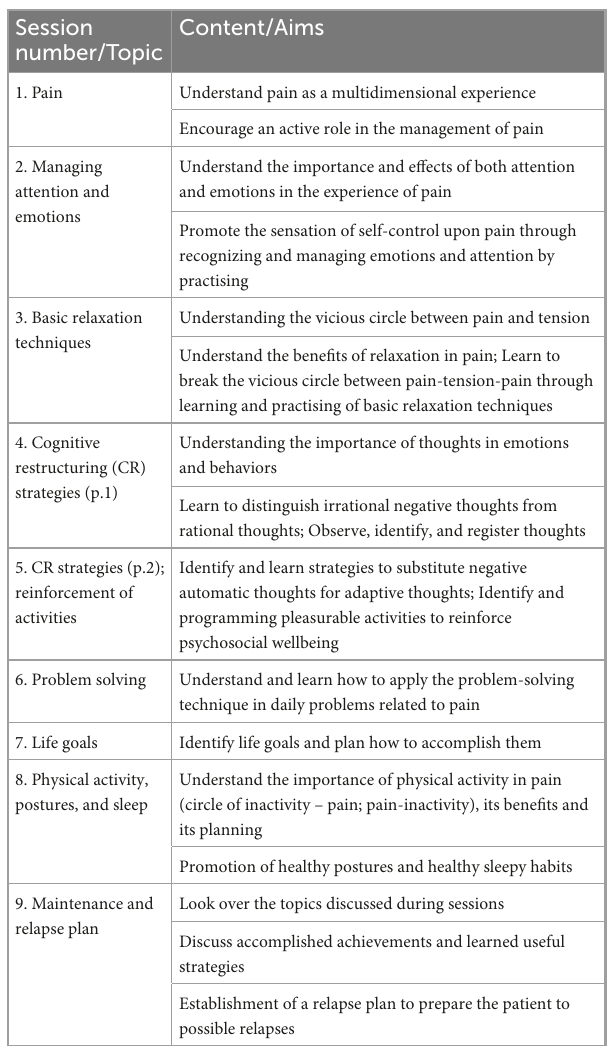
TABLE 1 Psychoeducational intervention program